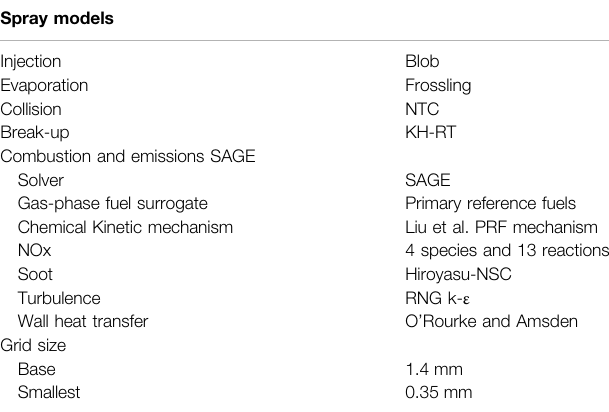
TABLE 2 | Primary CONVERGE